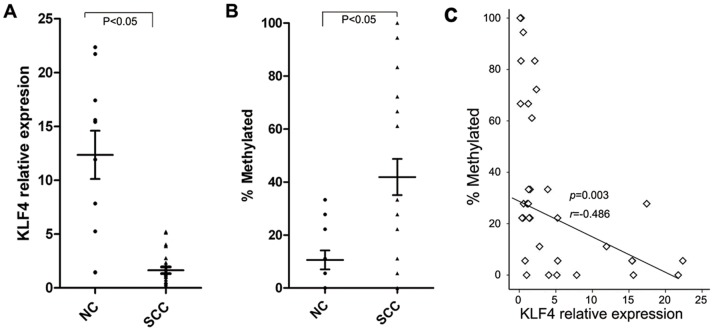
KLF4 promoter methylation is negatively correlated with the gene expression.(A) The relative mRNA levels of KLF4 in cervical cancer and normal cervix tissues. (B) The methylation ratio of the KLF4 promoter BSQ3 region. (C) An inverse correlation is observed between KLF4 promoter methylation and mRNA levels (r = −0.486, P = 0.003).